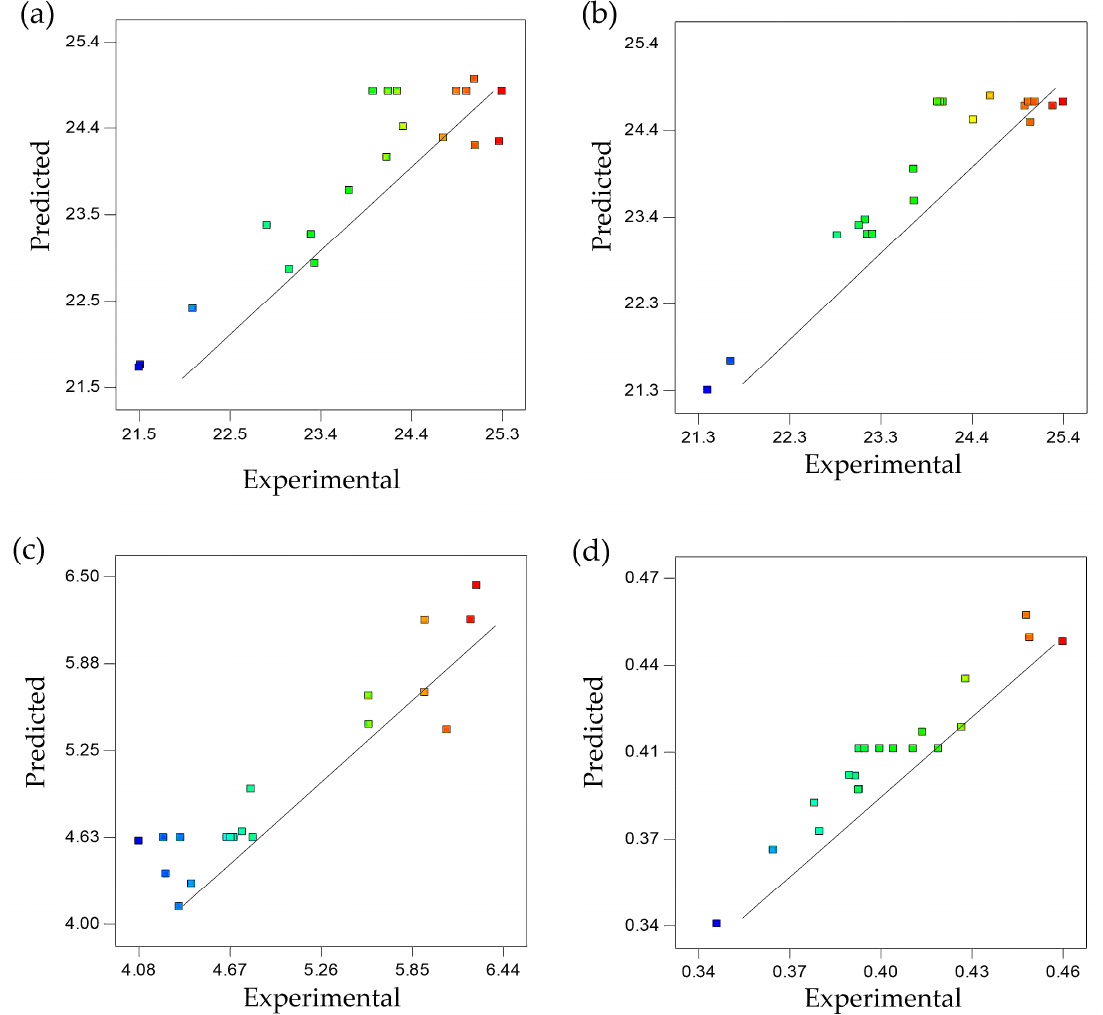
Figure 1. Experimental and predicted values for ( a ) tensile strength, ( b ) yield strength, ( c ) elongation, and ( d ) Young’s modulus of ultra-high molecular weight polyethylene/cellulose nanofibers (UHMWPE/CNF) bionanocomposites.